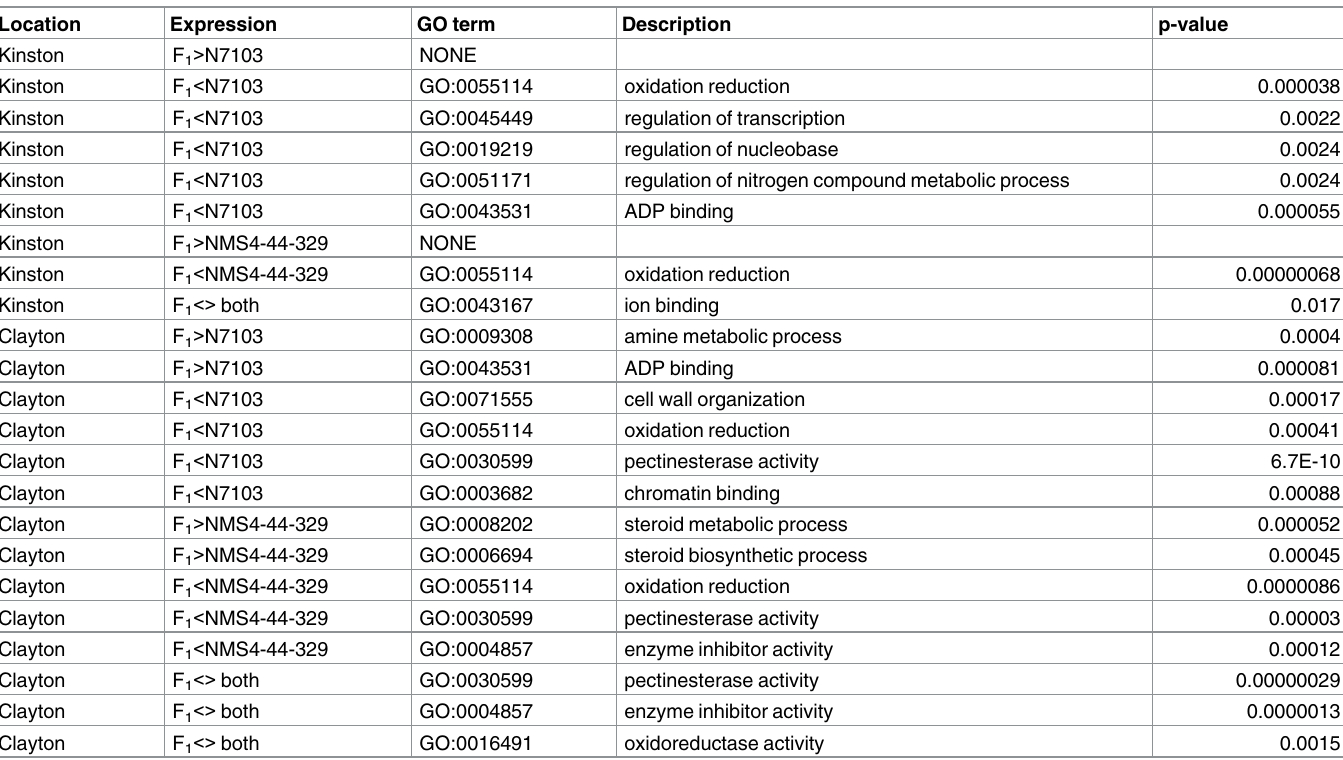
Table 5. Enriched